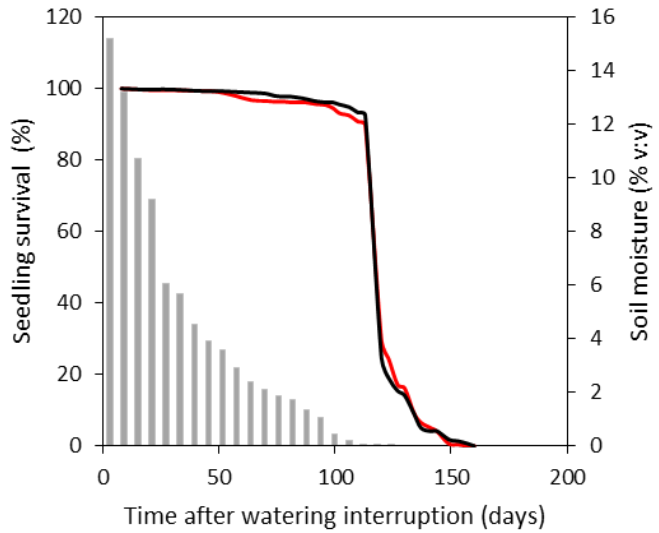
Figure 4. Survival (lines) and soil moisture (bars) in the death trial for seedlings from young (red line) and overmature (black line) mother trees. For the sake of clarity, trees are divided into two groups: young (<150 years old) and overmature (>150 years old).